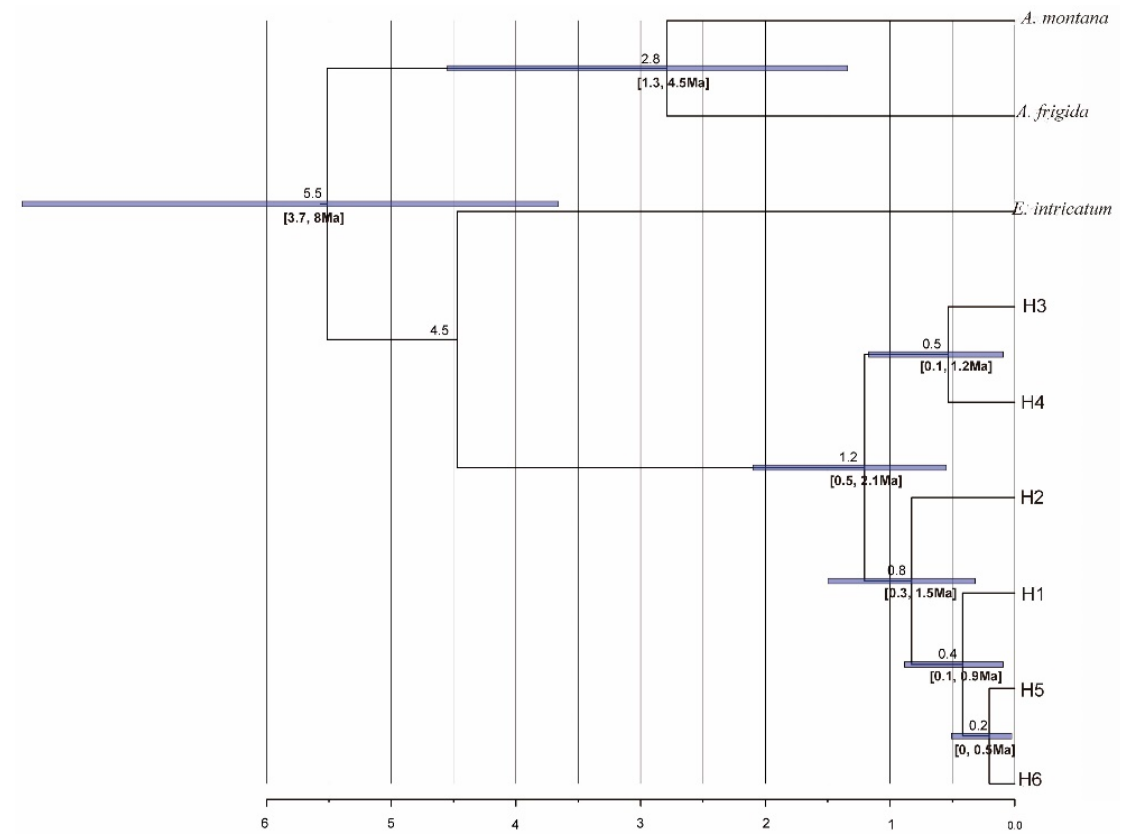
Figure 5. Bayesian divergence time estimates of S. centiflora based on the combined cpDNA data from two plastid gene markers ( trn Q- rps 16 and psb A- trn H). Blue bars on the nodes indicate 95% posterior credibility intervals.